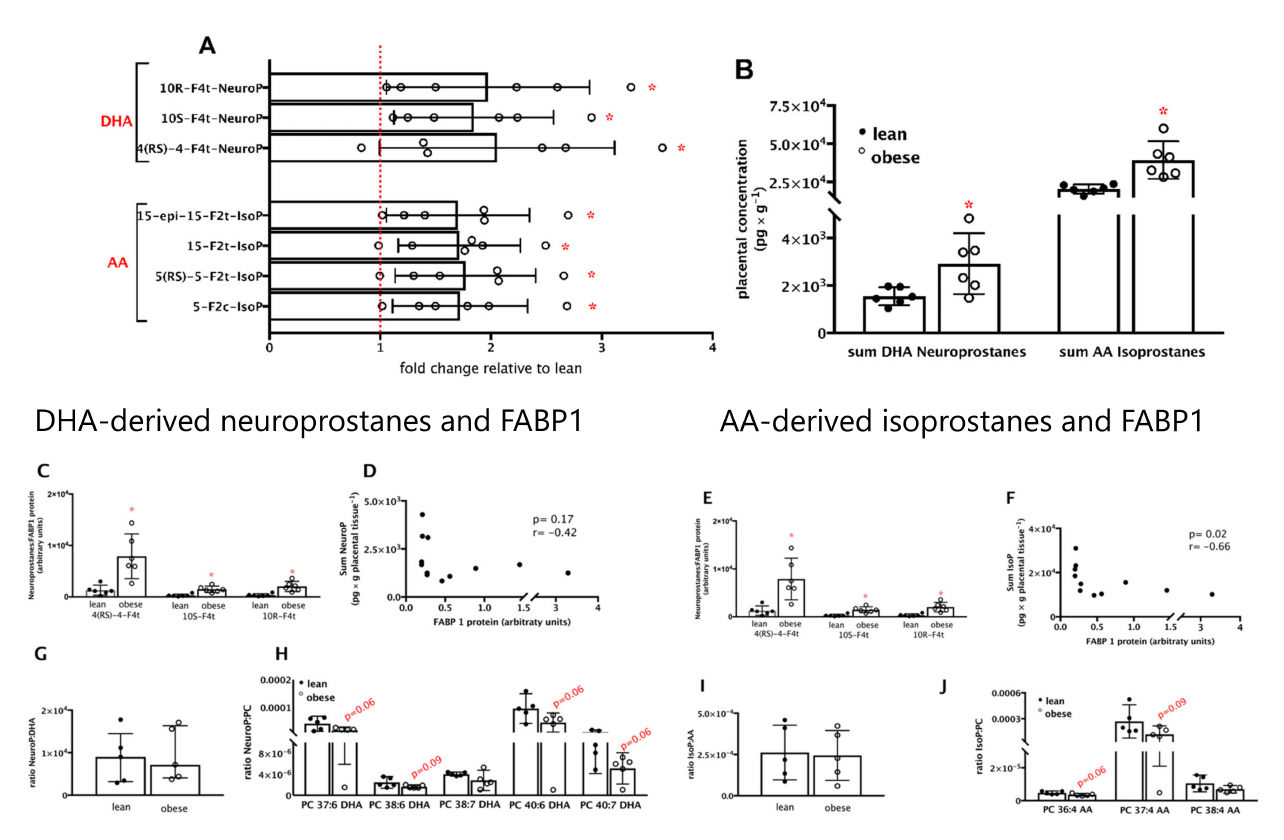
Figure 3. Neuroprostanes and isoprostanes are increased and negatively associated with FABP1 protein in placentas from women with pre-gestational obesity. Products of non-enzymatic peroxidation of the essential polyunsaturated fatty acids docosahexaenoic (DHA) and arachidonic (AA) in placental tissue were analyzed by target microLC–MS/MS. Three DHA-derived neuroprostanes (NeuroP) and four AA-derived isoprostanes (IsoP) were identified. Placentas from lean women ( • ) and from obese women ( ) were compared to investigate differences in DHA- and AA-derived isomers in (cid:35) placentas from obese relative to lean women ( A ) and in the sum of neuroprostanes and isoprostanes ( B ). The ratio of neuroprostane isomers to FABP1 and the respective Spearman correlations ( C , D ), and the ratio of isoprostanes to FABP1 and the respective Spearman correlations ( E , F ), were calculated to investigate possible associations between alterations in FABP1 and DHA and AA non-enzymatic peroxidation as a function of maternal pre-gestational obesity. Possible differences in the sources of neuroprostanes and isoprostanes induced by maternal pre-gestational obesity were assessed by the ratios of neuroprostanes to free DHA ( G ) and to DHA-phosphatidylcholine species (PC; H ), and isoprostanes to free AA ( I ) and to AA-phosphatidylcholine species (PC; J ). * Significantly different from the lean group; p < 0.05 (Mann–Whitney